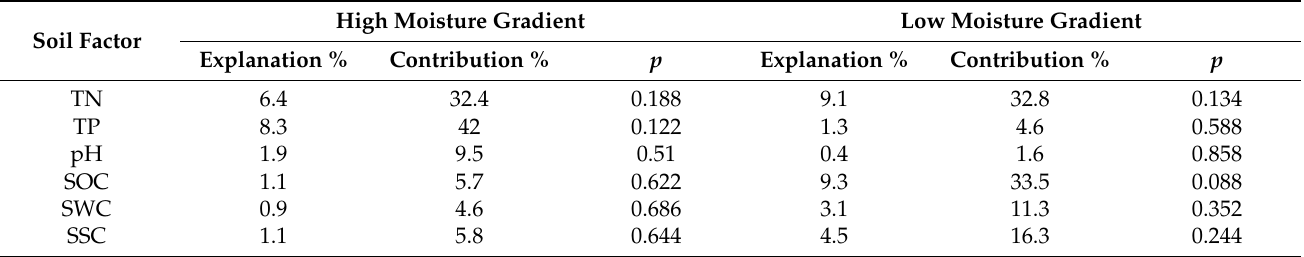
Table 4. Soil factor RDA: explanation rates of plant functional trait variation and environmental variables under different soil water